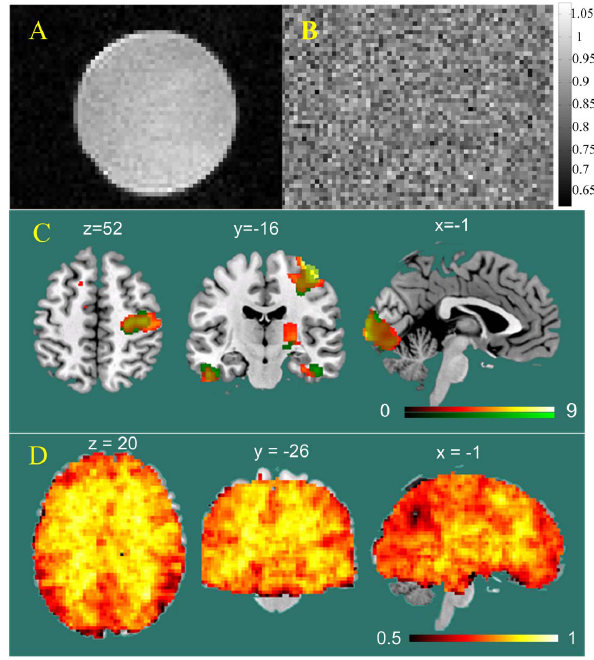
Figure 1. Evaluations of entropy mapping using fMRI. A) image of a cylinder water phantom; B) entropy map of the phantom. The color bar indicates the display color window for the entropy map; C) visual and sensorimotor functional activation induced brain entropy decrease as compared to the resting state. Red and green represent the test (session 1) and retest (session 2) experiment, respectively. The color bars indicate the color window used to display the statistical comparison results (t maps of the paired student t-testing). The statistical threshold for identifying the entropy decreasing clusters is p , 0.001 and cluster size . 30 (uncorrected for multiple comparisons); D) the correlation coefficient (CC) map of 50 subjects’ resting BEN maps. The color bar was used to map the CC value from 0.5 to